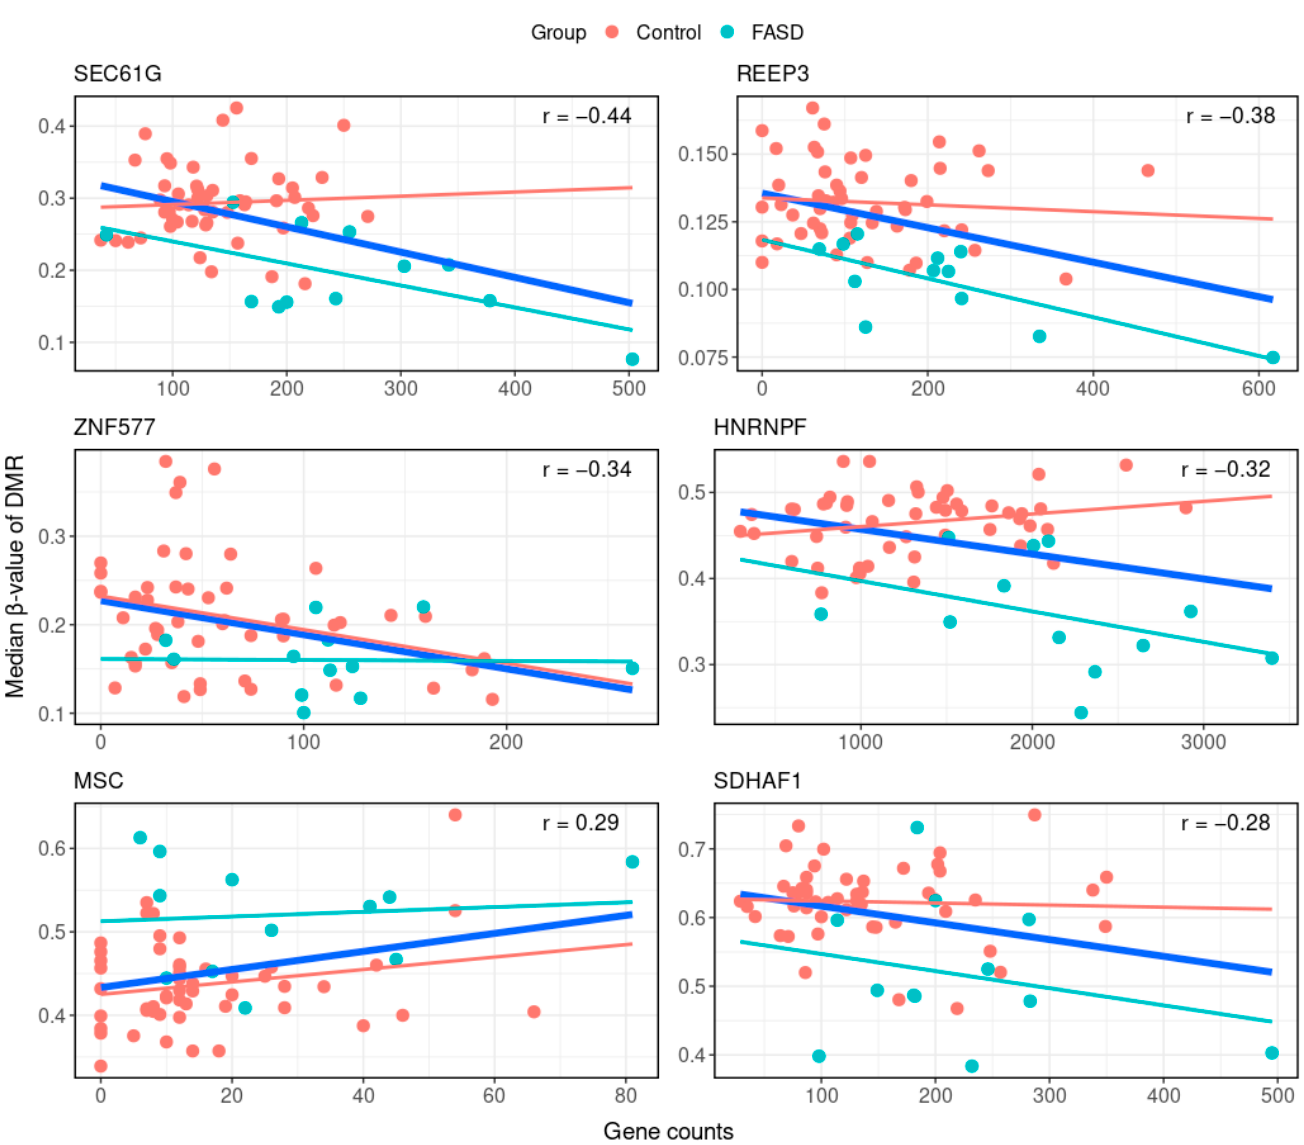
Figure 2. eQTMs. Top six signi fi cant DMR–gene expression eQTMs associated with FASD. X-axes represent gene counts, Y-axes represent median β -values of the eQTM-associated DMR. Each sample is represented by a dot, where blue dots are samples of individuals with FASD and red dots are samples of healthy controls. Relationships between DMR methylation and gene expression are given by linear correlation lines. The thick blue line represents the eQTM from the combined analysis of FASD and control data, for which Pearson’s correlation coe ffi cient is also given. Thin lines are group-speci fi c correlations.